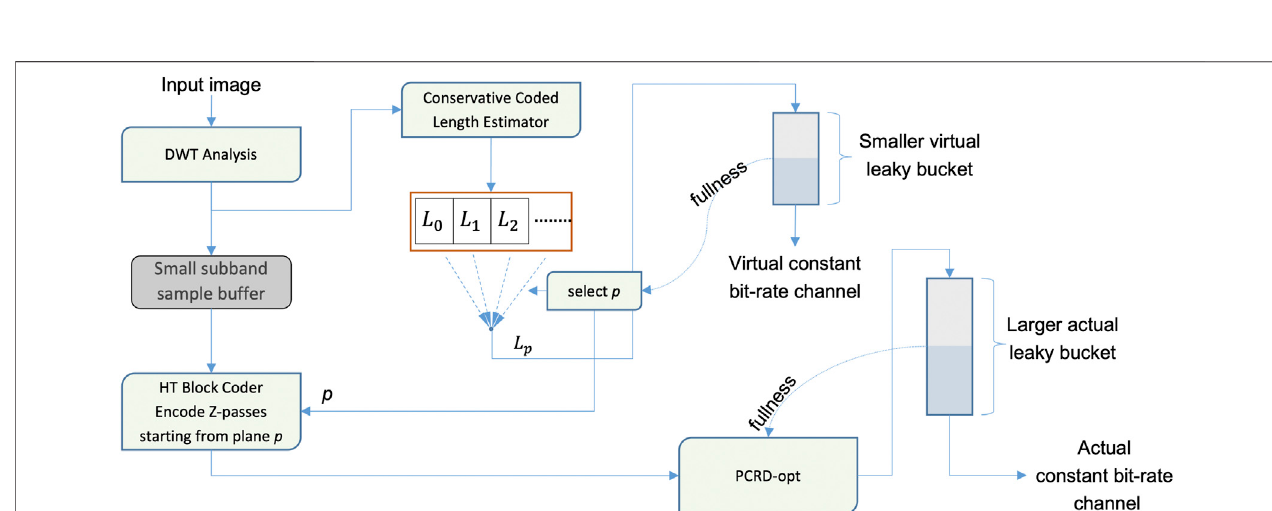
FIGURE 6 | Decoupled virtual (CPLEX) and actual (PCRD-opt) rate control processes for memory ef fi cient video encoding.